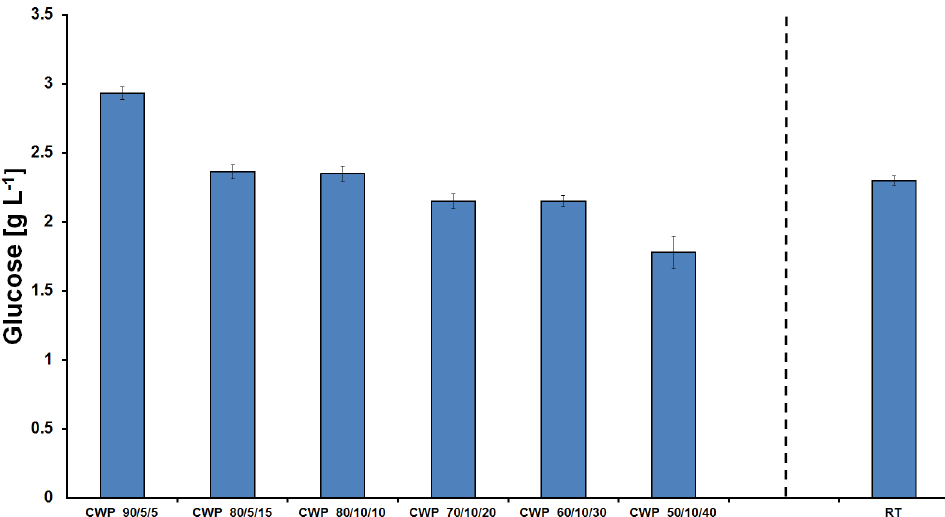
Figure 4. HPLC-RI measurements of recovered glucose from enzymatic degradation of cellulose material depending on cellulose (C), wool (W) and polyester (P) content. RT= real textile waste sample.